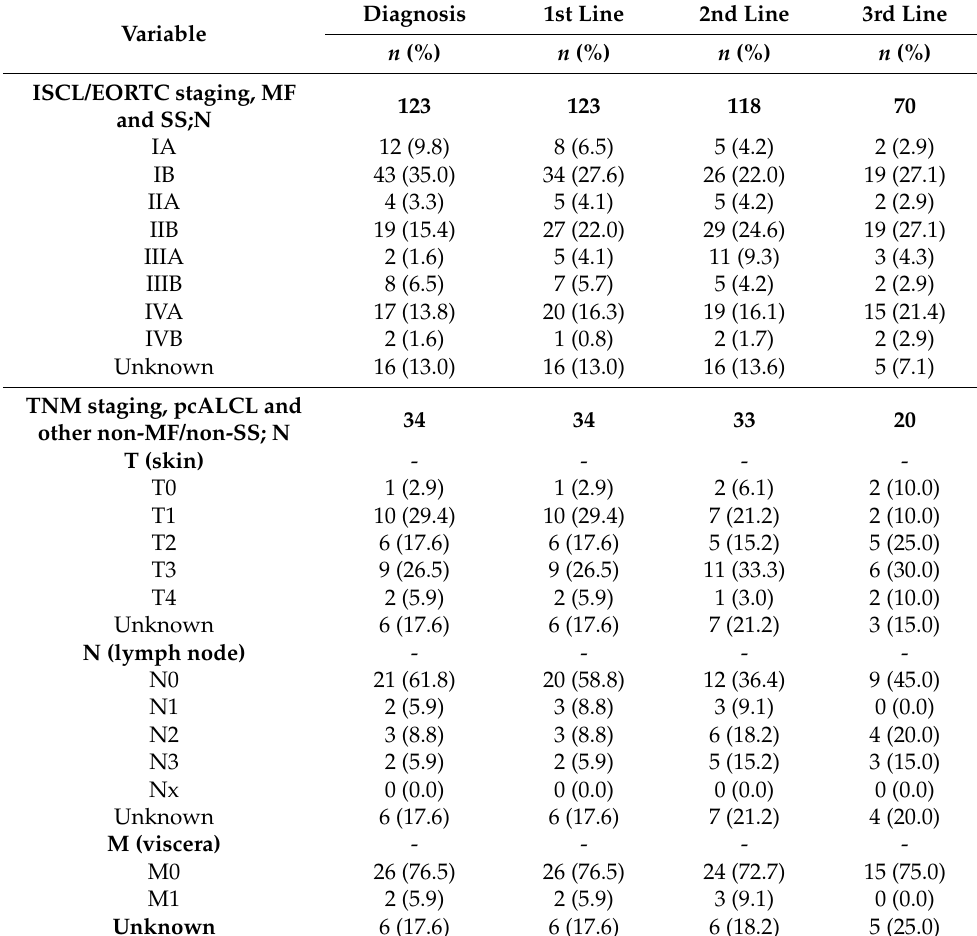
Table 2. Disease stage at diagnosis and prior to treatment initiation in 1st, 2nd and 3rd